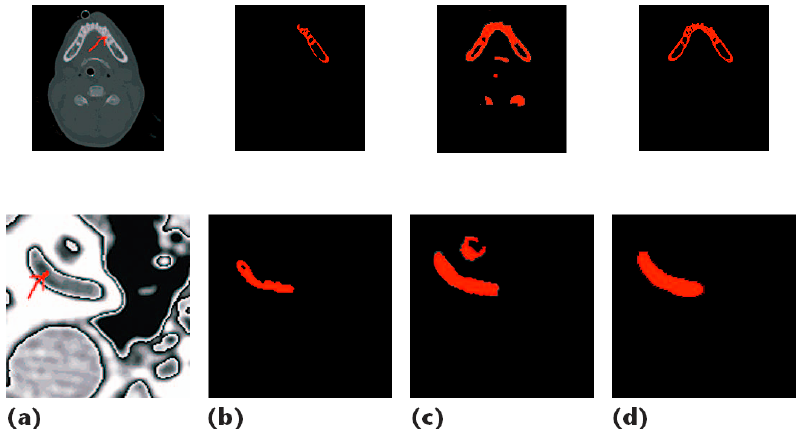
Figure 6. Analysis of the results of a general region-growing algorithm: ( a ) Original image (red arrow points to things (teeth and auris) to be segmented); ( b ) segmentation results from region growing using parameters r = 30; ( c ) results obtained using the robust split-and-merge algorithm; ( d ) the results showed that the edges of the images are more exact and smoother [53].